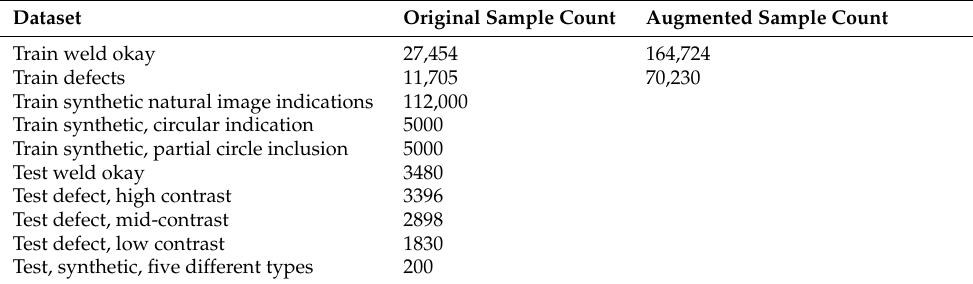
Table 1. Overview of the different datasets utilized. For the experimental data, the original sample count refers to the number of unique patches extracted with random translation and rotation from the original full-sized image input; for the synthetic data, the original sample count refers to the number of unique random realizations. See the text for